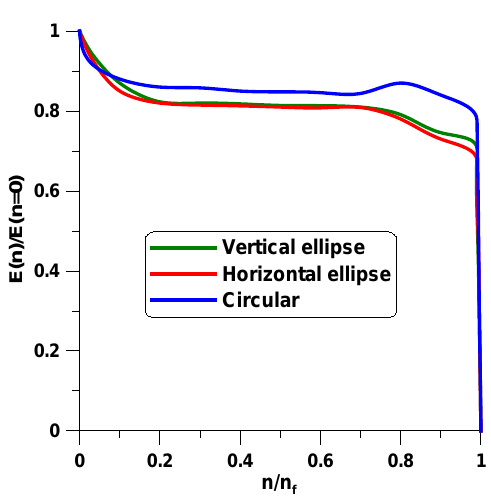
Figure 14. Variations of the global plate Young’s modulus versus the number of cycles.